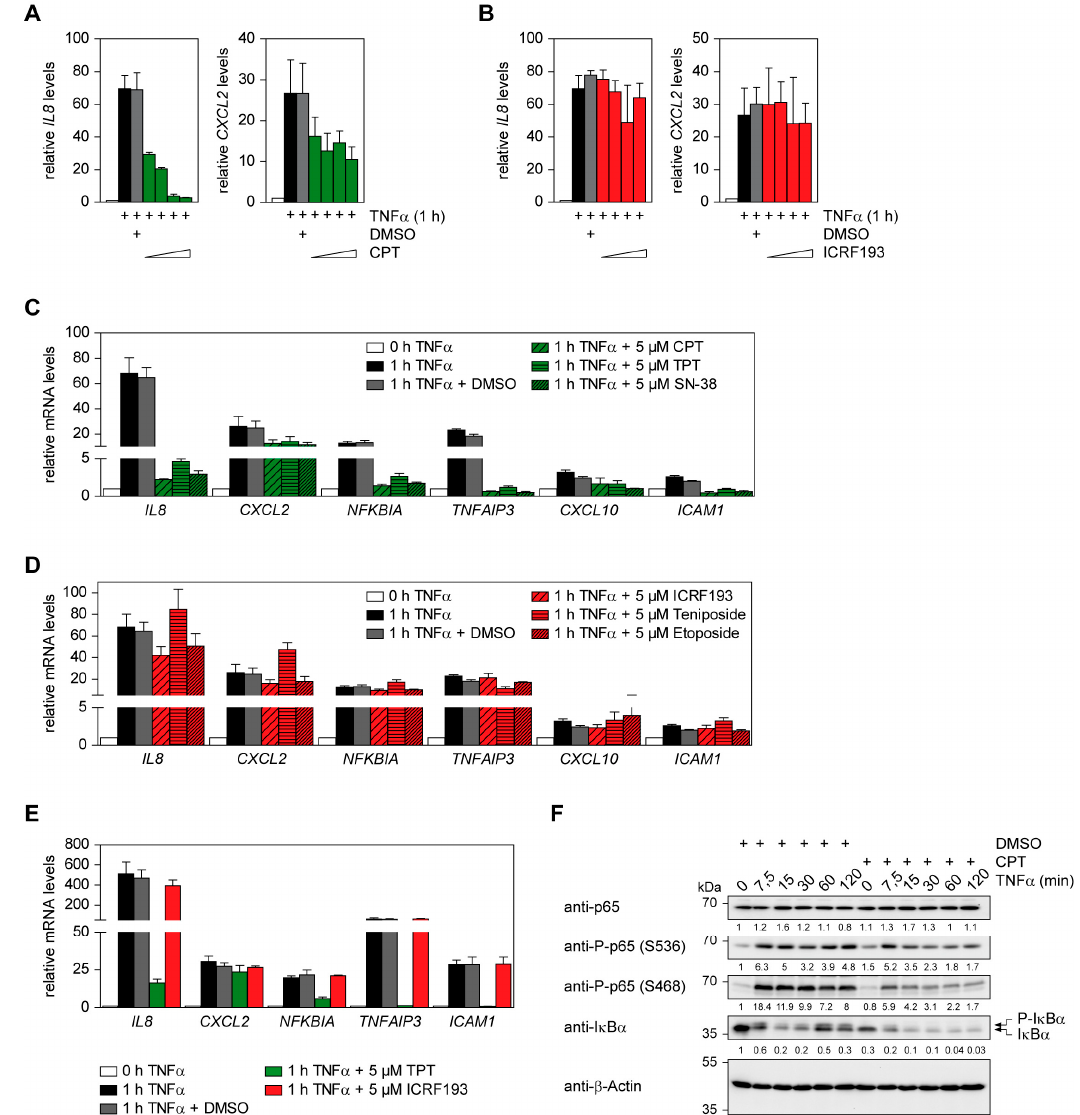
Figure 1. Effect of TOP1 and TOP2 inhibitors on TNF α -induced inflammatory gene expression in HCT116 and FS4-LTM cells. ( A , B ) HCT116 cells were pre-treated for 2 h with increasing (0.5 µM, 1 µM, 5 µM, 10 µM) concentrations of CPT ( A ) or ICRF193 ( B ) or vehicle (DMSO) in the controls